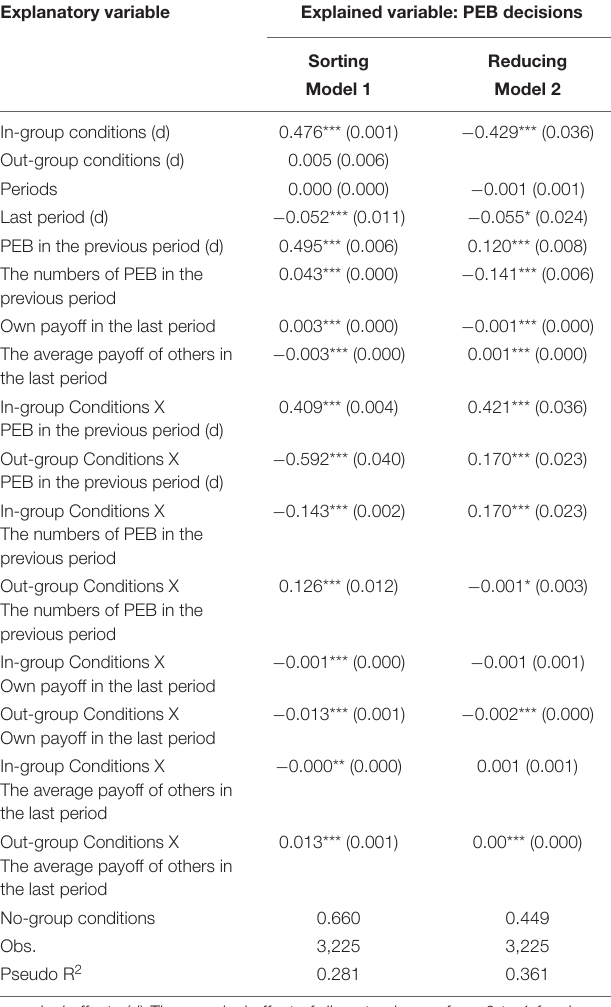
TABLE 10 | Probit regression results of group conditions on two PEBs.